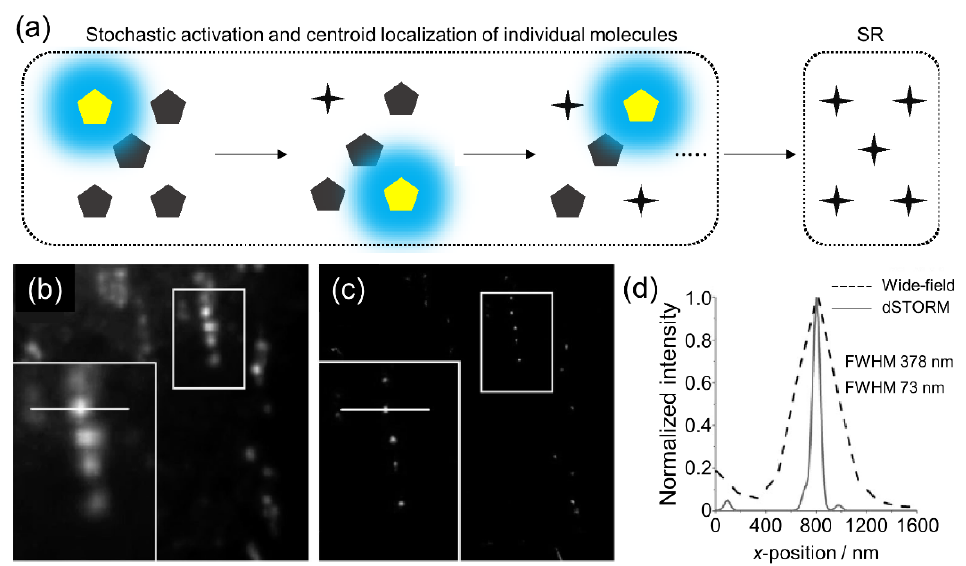
Figure 2. ( a ) Schematic showing the repeated cycling principles of STORM. Comparison between the ( b ) wide-field and ( c ) dSTORM images of mitochondrial DNA with ( d ) line-intensity profiles. Images ( b – d ) were reproduced with permission from Benke et al., published by John Wiley and Sons, 2011 [25].